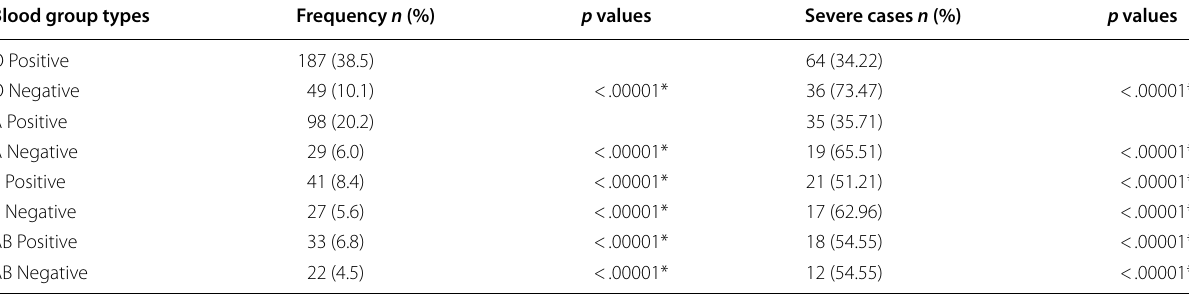
Values with an asterisk (*) are significantly different from O and A positive at p < 0.05 (Chi-square test)